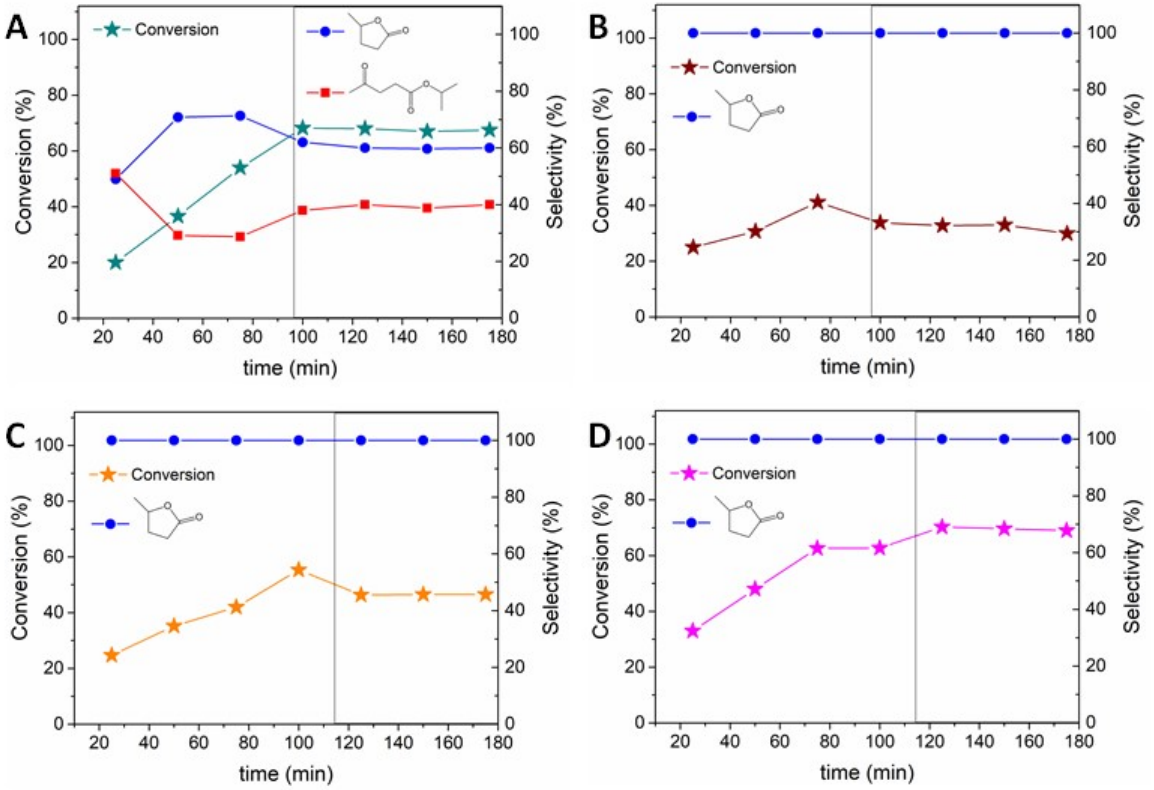
Figure 5. Catalytic performance in terms of stability, along run times of 180 min for ( A ) UiO-66, ( B ) 1%Ni/UiO-66, ( C ) 3%Ni/UiO-66, ( D ) 5%Ni/UiO-66.